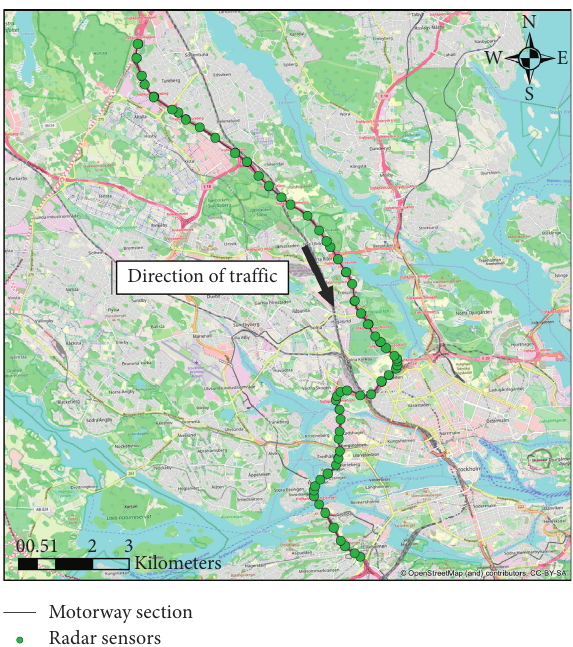
Figure 2: Modelled motorway section and the sensors’